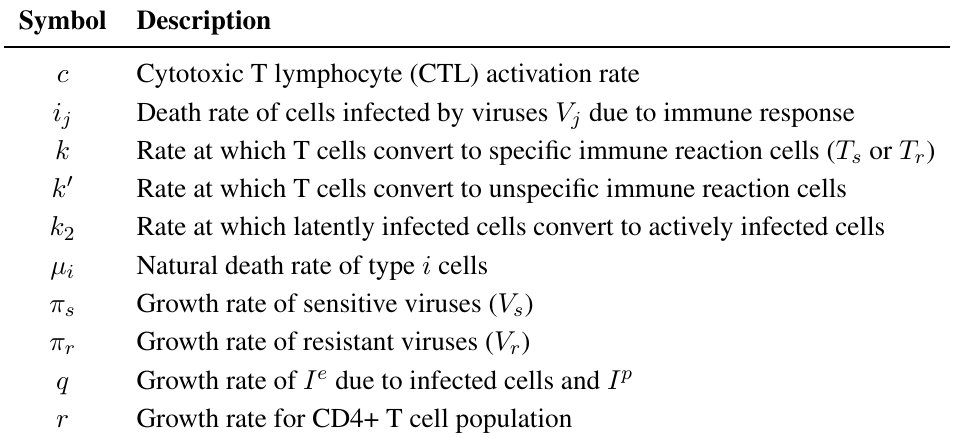
Table 3. Parameters (Unit of measure: 1 /day